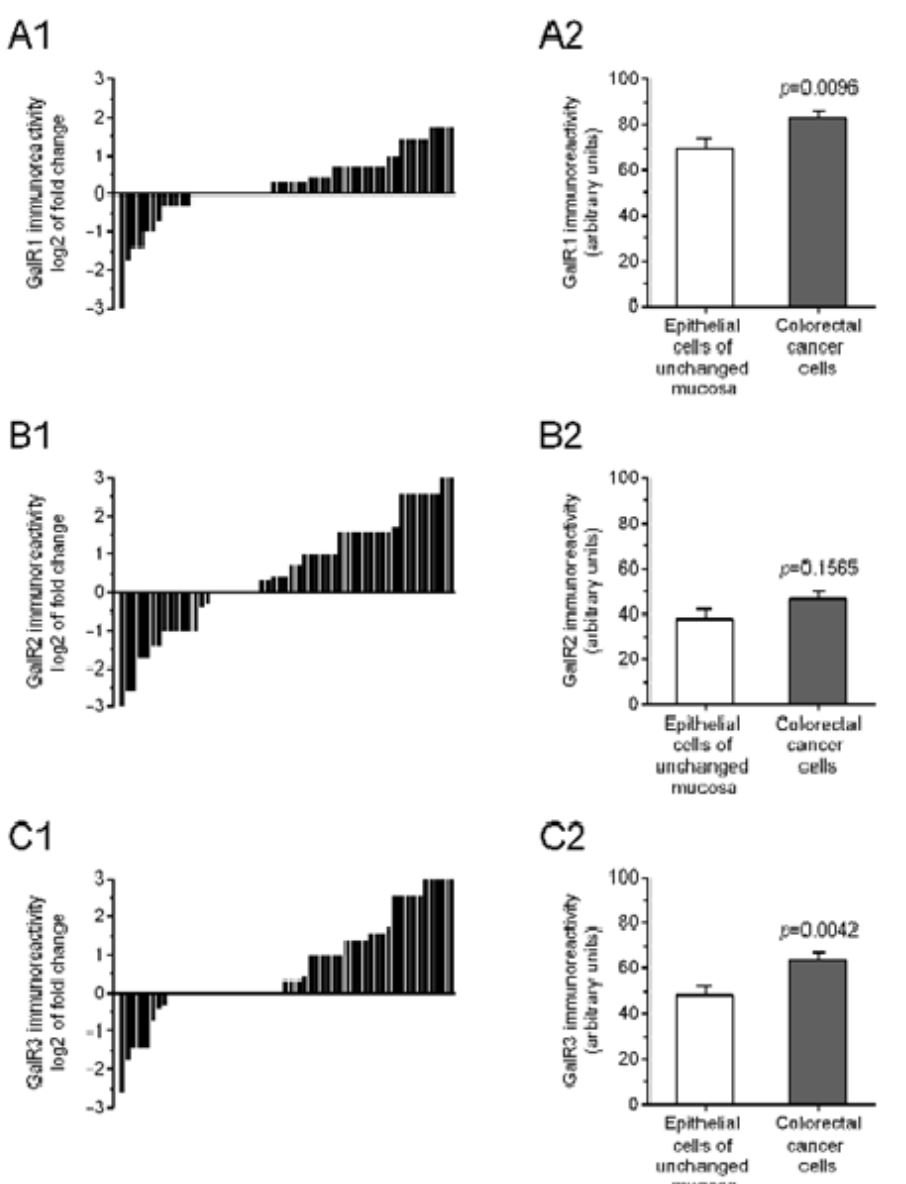
Figure 2. Immunoreactivity of three types of galanin receptor GalR1 ( A1 ), GalR2 ( B1 ) and GalR3 ( C1 ) proteins in tumor sections of individual colorectal cancer (CRC) patients is shown in relation to their immunoreactivity in matched sections of unchanged mucosa. The average immunoreactivity of GalR1 ( A2 ), GalR2 ( B2 ), and GalR3 ( C2 ) proteins in CRC cells (grey bars) compared with their immunoexpression in the epithelial cells of unchanged mucosa (white bars) was determined as described in the Methods ( n = 55).